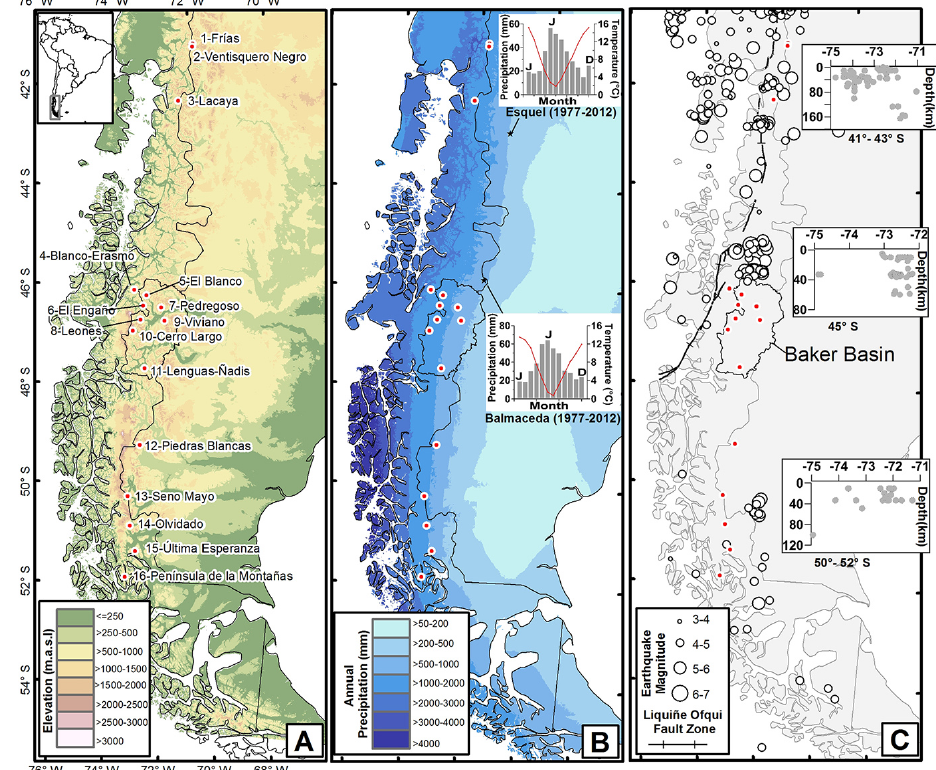
Figure 1. (a) Geographical setting and name (unofficial) of failed moraine-dammed lakes in Patagonia used to develop a GLOF susceptibility classification scheme. (b) Failed dams are located in zones with annual precipitation ranging from 500 to 2000mm and where mean monthly temperature in winter is generally above 0 ◦ C. (c) Note the decrease in the number and magnitude of earthquakes south of the 46 ◦ S and the high frequency of shallow earthquakes (hypocentre < 30km). Climate data extracted from Hijmans et al. (2005) and from the National Climatic Data Center (http://www.ncdc.noaa.gov). Seismic data (period 1973–2012) retrieved from the Northern California Earthquake Data Center